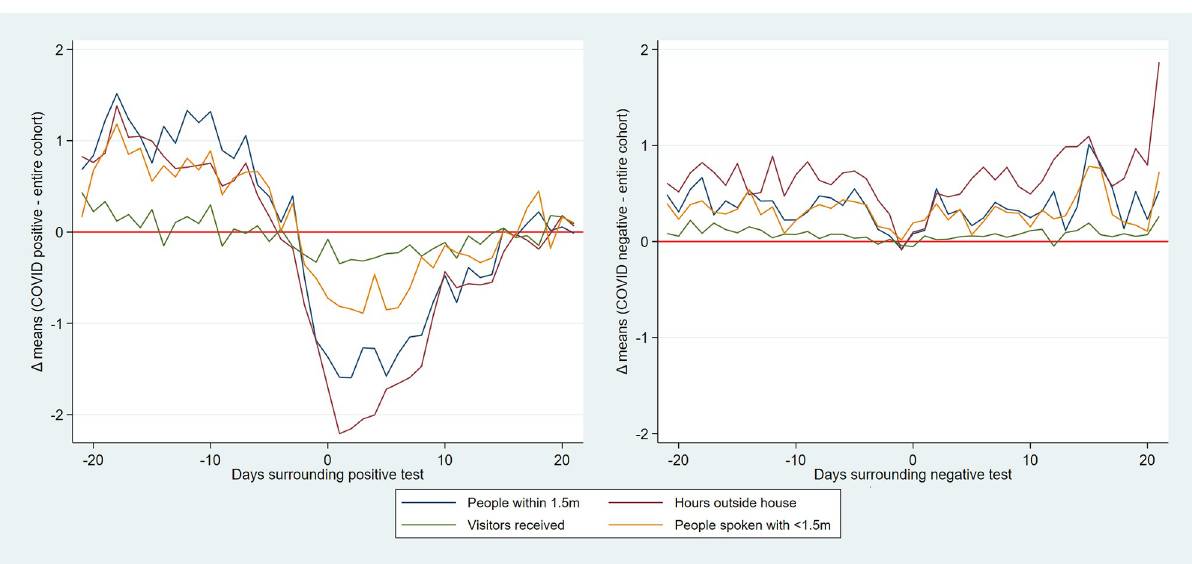
Sensitivity analyses These analyses were repeated using (a) only users reporting an above median number of obser- vations (referred to as ‘faithful’ users), (b) only users outside the province Zuid-Holland, and (c) only non-healthcare professionals. Differences in the results for these three sensitivity